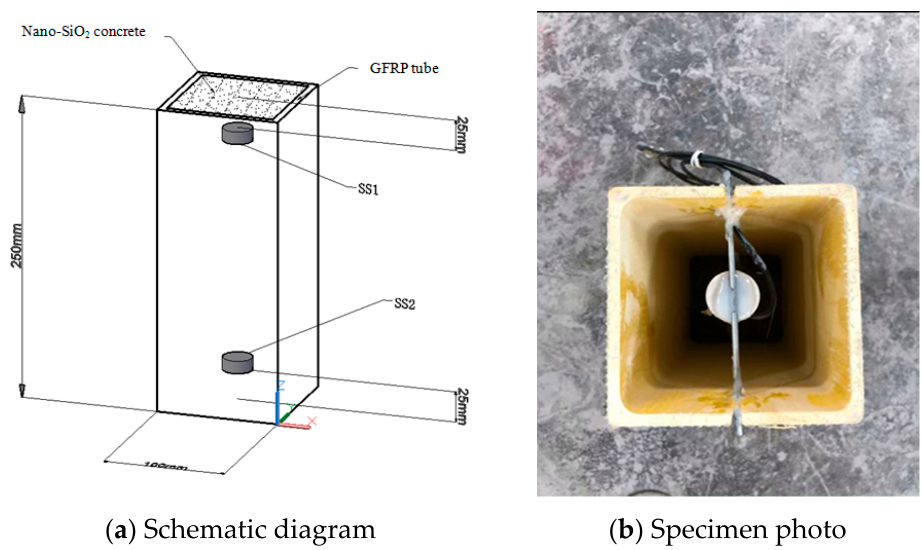
Figure 2. Schematic diagram and specimen photo of short glass fiber reinforced polymer (GFRP) concrete column.